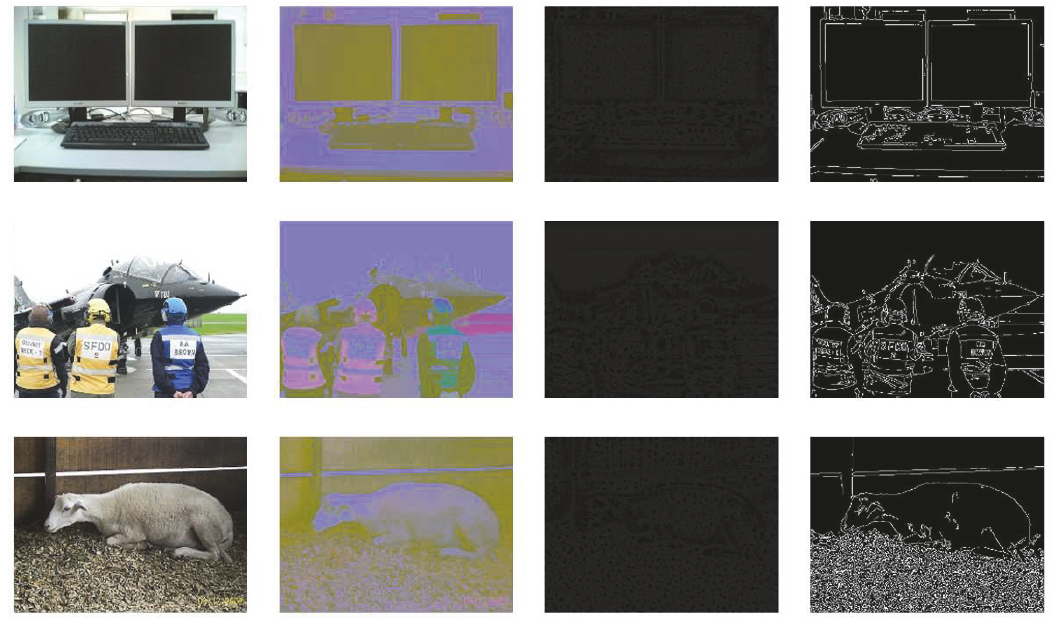
Figure 2: Different features extracted for images. Right to left: original images, LAB color, LBP texture, and Canny edges. Top to bottom: No. 000121, No. 000480, and No.